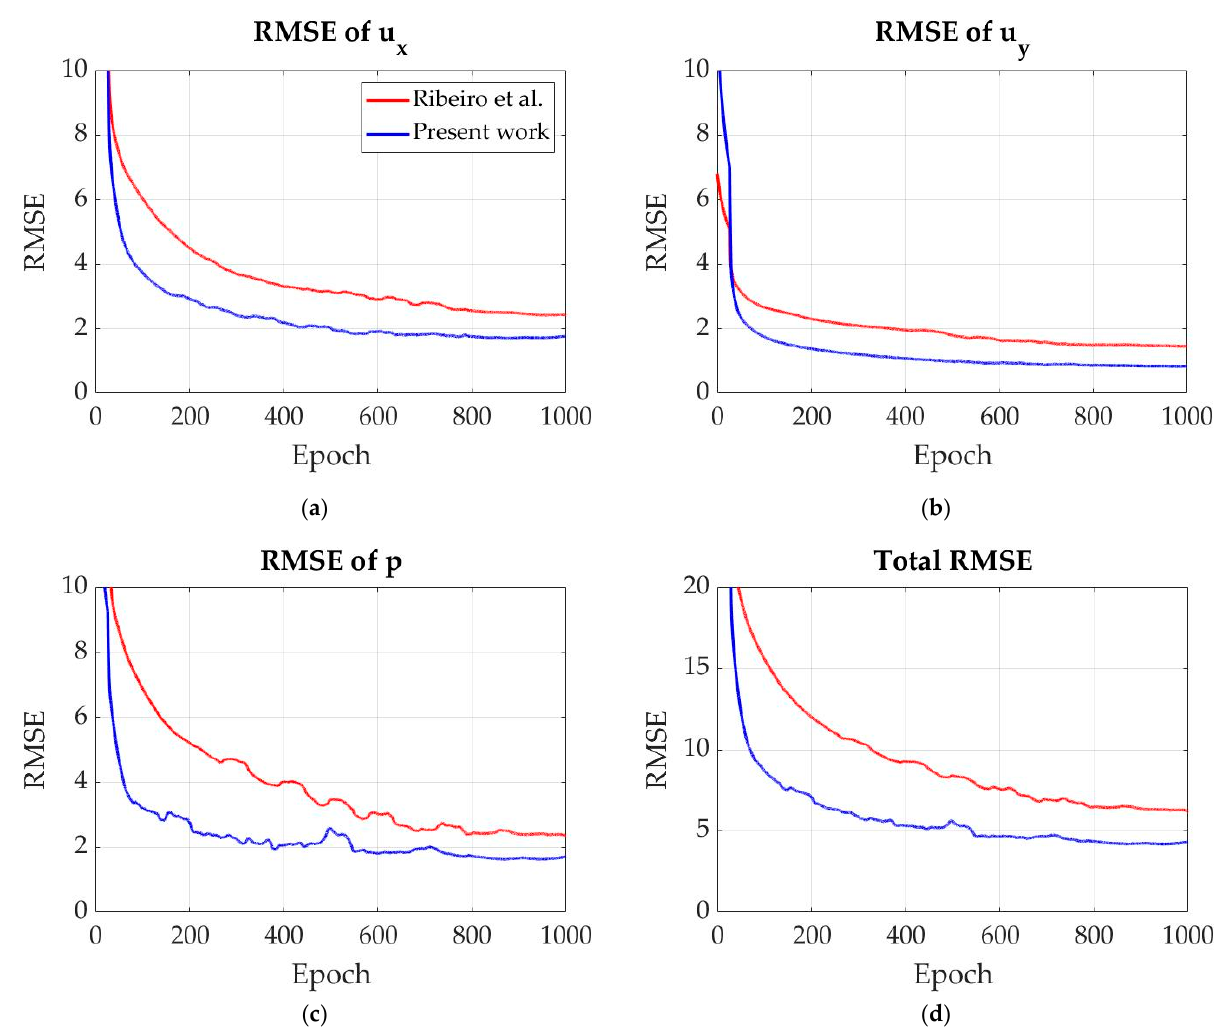
Figure 6. Comparison of the obtained training error curves with the ones obtained with the net of Ribeiro et al. [13] for 1000 epochs. ( a ) RMSE or u x ; ( b ) RMSE of u y ; ( c ) RMSE of p ; ( d ) Total